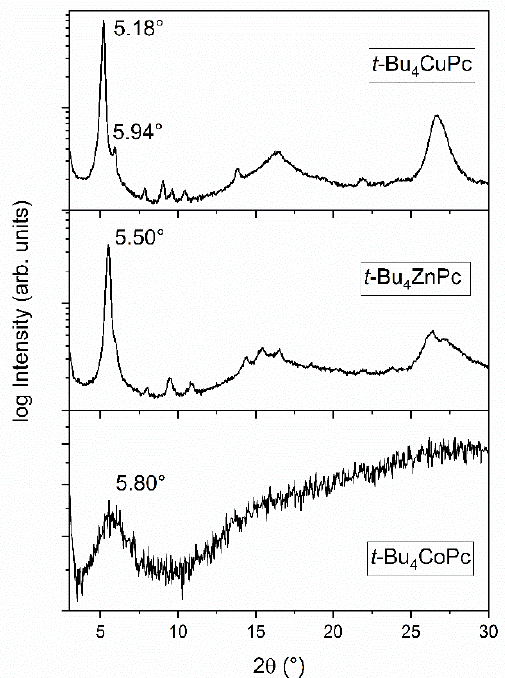
Figure 2. XRD patterns of tetra- tert -butyl-substituted Cu-, Zn- and Co-phthalocyanine. G. Sfyri et al. [43] reported the grazing incidence XRD pattern of t -Bu 4 CuPc film, showing two low-angle reflections at 5.18 ◦ and 5.92 ◦ , well in agreement with our data (see Figure